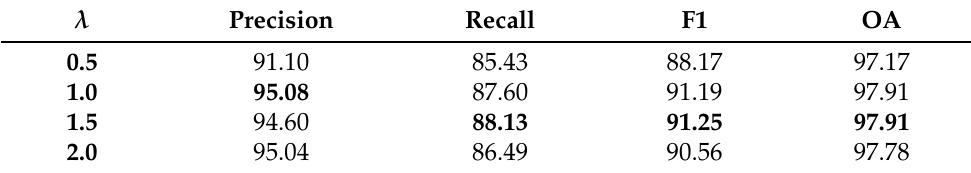
Table 5. Quantitative results of the effect of λ on CDD with 6000 pairs images. λ